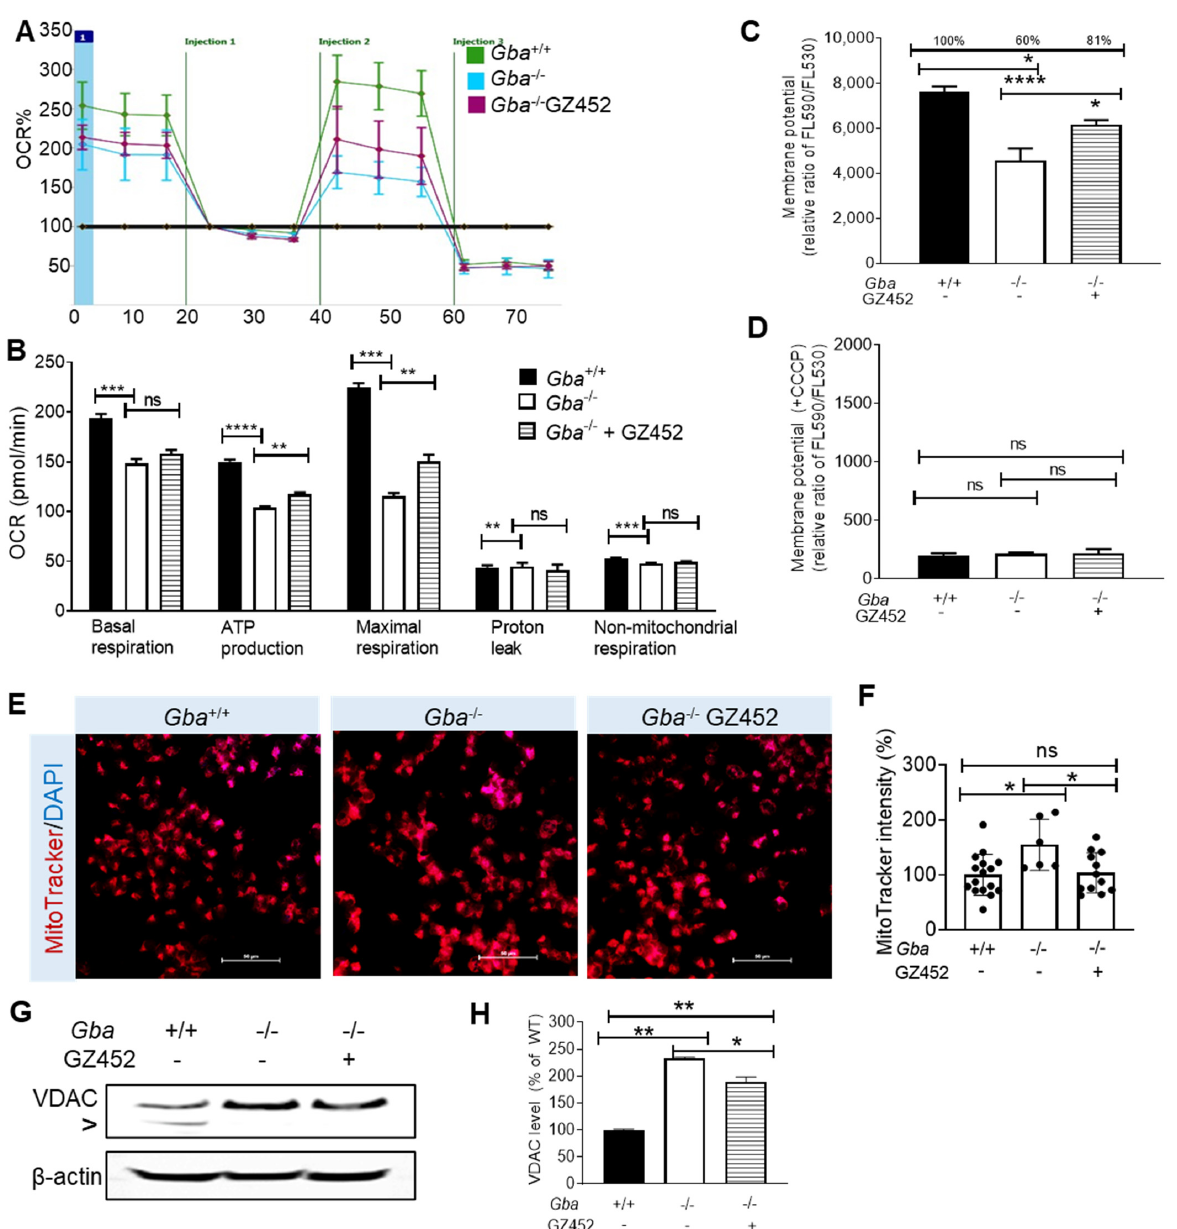
Figure 2. GZ452 treatment improved mitochondrial function. ( A ) Seahorse analysis of oxygen consumption rate (OCR) in Gba +/+ , Gba -/- , and GZ452-treated Gba -/- neurons. ( B ) Quantitation of OCR data showed ATP production and maximal res- piration was increased in GZ452-treated Gba -/- neurons (triplicate experiments, n = 4 per experiment). ( C,D ) Mitochondrial membrane potential (MMP) assay. GZ452 treatment significant improved MMP in Gba -/- neurons ( C ). CCCP treatment disrupted MMP in neurons as a negative control ( D ) (triplicate experiments, n = 4 per experiment). ( E ) MitoTracker-stained mitochondria (scale bar = 50 µM). ( F ) Quantitation of MitoTracker density in cells showed reduced signals in GZ452-treated Gba -/- neurons compared with untreated Gba -/- neurons ( n ≥ 6 images from triplicate experiments). ( G ) VDAC and β -actin were measured by WB. “>” points a non-specific band. ( H ) Quantitation data showed GZ452 treatment reduced VDAC protein (normalized by β -actin) level in Gba -/- neurons (duplicate experiments). One-way ANOVA (* p < 0.05; ** p < 0.01; *** p < 0.001; **** p < 0.0001). ns, not statistically significant.